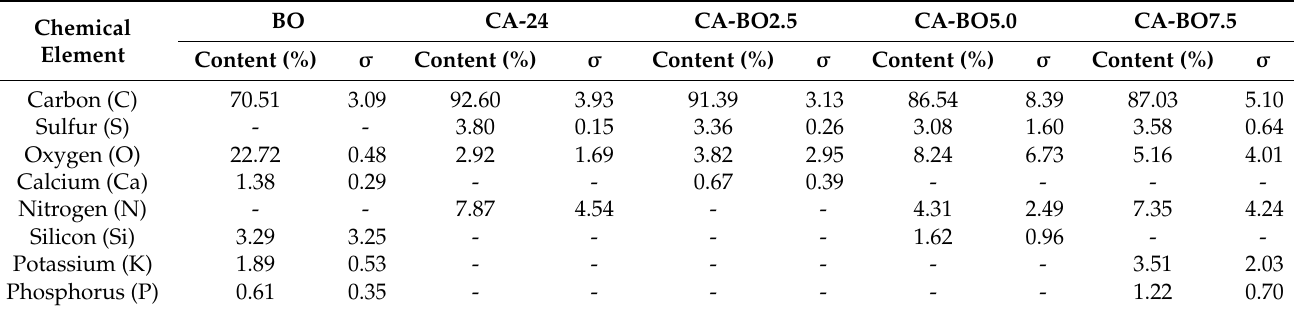
Table 3. Micro elemental analysis of the